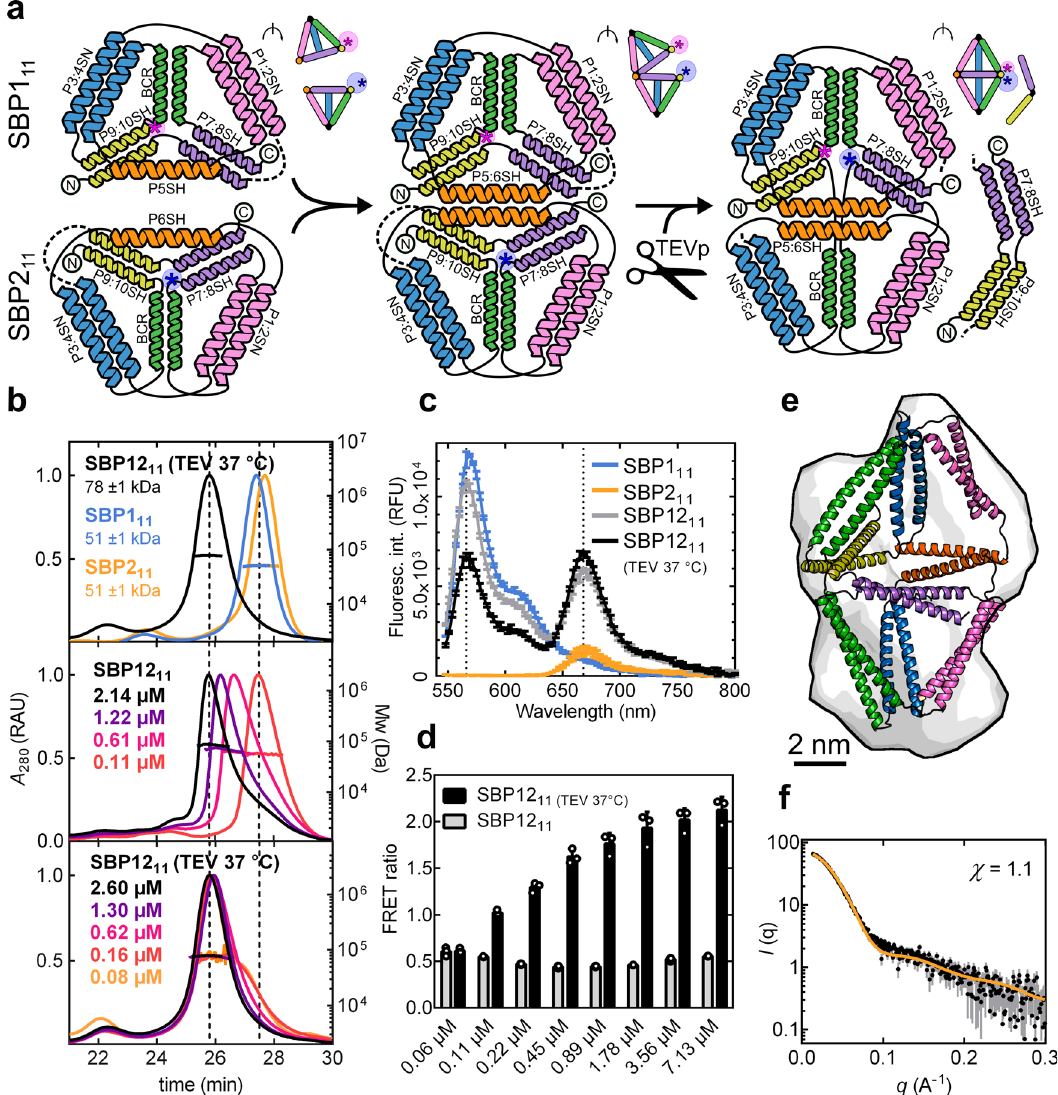
Fig. 4 Proteolysis-triggered assembly of the two-chain bipyramidal cage SBP12 11 . a Topological scheme of the protein SBP12 11 before and after TEV proteolytic cleavage; N- and C-termini are indicated with circled letters and the positions of fl uorophores are indicated as asterisks. Coloured helices represent different CC-forming segment pairs. The linkers containing the TEV protease cleavage sites are represented with dotted lines. Upper panels show a schematic representation of the protein complex rotated of 60°, indicating the positions of fl uorophores as asterisks. b SEC-MALS chromatograms: top panel shows individual subunits SBP1 11 and SBP2 11 before cleavage (cyan and orange traces, respectively) and the complex SBP12 11 after treatment with TEV protease (black trace). Central and bottom panels show the complex SBP12 11 before and after structural rearrangement, eluting in different states at different concentrations. The concentration values correspond to the protein concentrations in the eluted peaks. Molecular weights were calculated from the light scattering signal observed across the main peaks eluting from a size-exclusion column. The theoretical molecular weights of the proteins before cleavage were Mw(SBP1 11 ) = 50.8 kDa and Mw(SBP2 11 ) = 51.8 kDa and after TEV cleavage Mw(SBP1 11 ) = 40.0 kDa and Mw(SBP2 11 ) = 41.7 kDa. UV signal is reported in relative absorbance units (RAU). c Fluorescence spectra of the two subunits SBP1 11 and SBP2 11 labelled with sulfo-cy3 and sulfo-cy5, respectively (cyan and orange traces, respectively) and of the complex SBP12 11 before and after treatment with TEV protease (grey and black traces, respectively). Error bars represent the standard deviation of three measurements of the same samples ( n = 3). The fl uorescence signal is reported in relative fl uorescence units (RFU). d The bar graph shows the FRET ratio calculated from measurements at different concentrations of the complex SBP12 11 before and after treatment with TEV protease (grey and black traces, respectively). Error bars represent the standard deviation of three measurements of the same samples ( n = 3). e SAXS ab initio reconstruction superimposed on the molecular model of the complex SBP12 11 that best fi t the experimental data. f SAXS pro fi le of the complex SBP12 11 after TEV cleavage and removal of the cleaved dipeptide segments (black trace) superimposed on the theoretical SAXS pro fi le of the best- fi t model ( χ = 1.1) (orange trace). Error bars in grey represent the standard deviation for each data point in black (mean). Source data are provided as a Source Data fi protease, the incubation at 37 °C promoted an increase in the FRET measured at different concentrations indicated that FRET signal at high concentrations, albeit 50% lower in proteolytic cleavage promoted a structural rearrangement in comparison to the signal obtained for the complex that was the heterodimeric bipyramid upon dissociation of the masking incubated with TEV protease (Supplementary Fig. 10). Overall, CC segments.